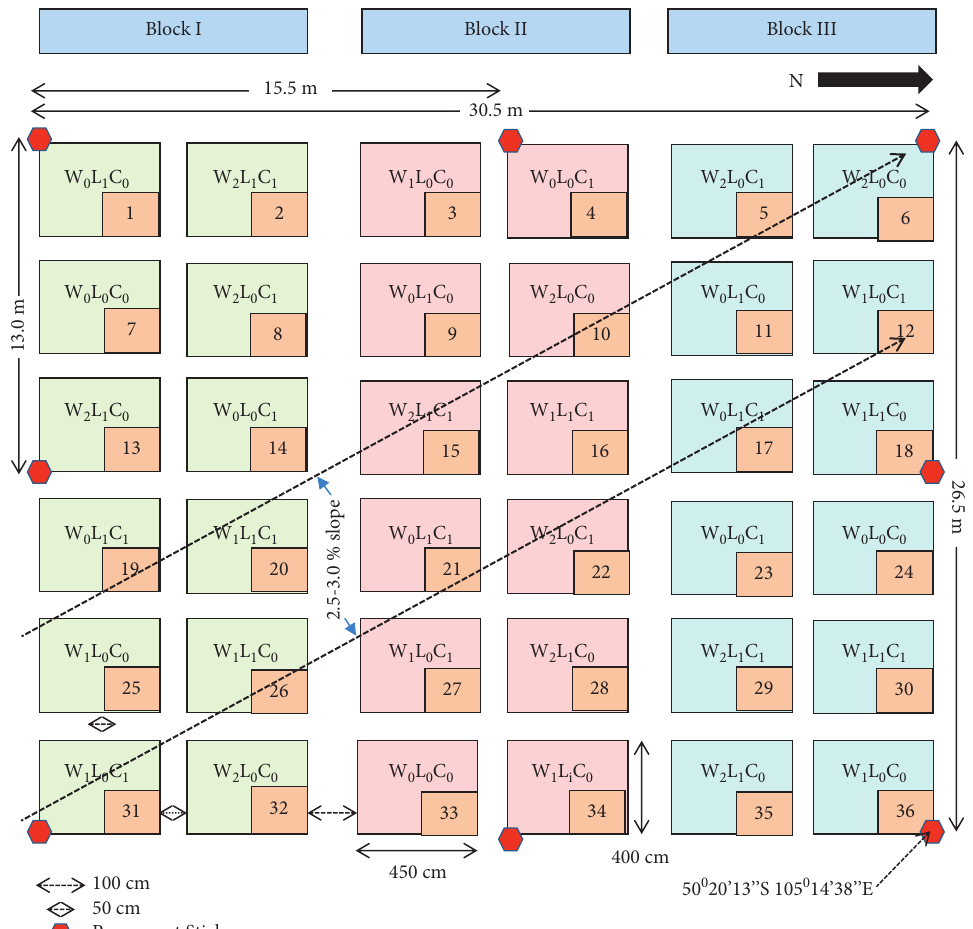
Figure 2: The arrangement of the experimental plots set in 1998 ( W � industrial waste, W L 1 � 5Mg calcite · ha − 1 ; C � cassava-leaf compost, C 0 � 0, C 1 � 5 Mg · ha − 1 ).